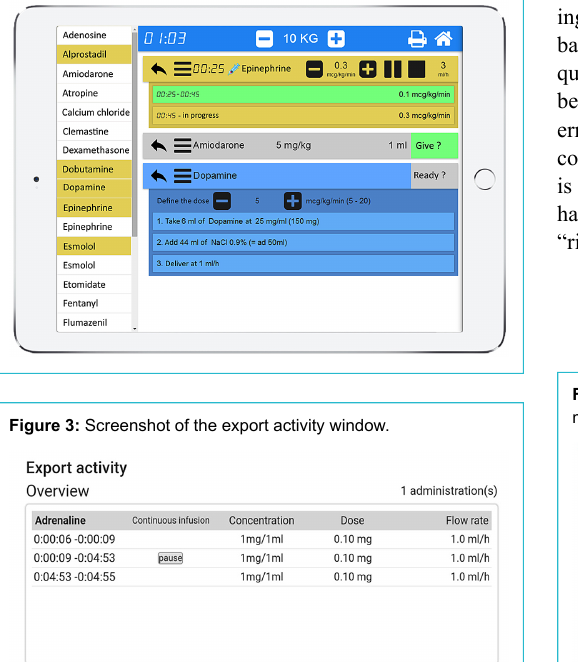
Figure 2: PedAMINES screenshot. List of bolus intravenous drugs (white boxes) and drugs for continuous infusion (yellow box-